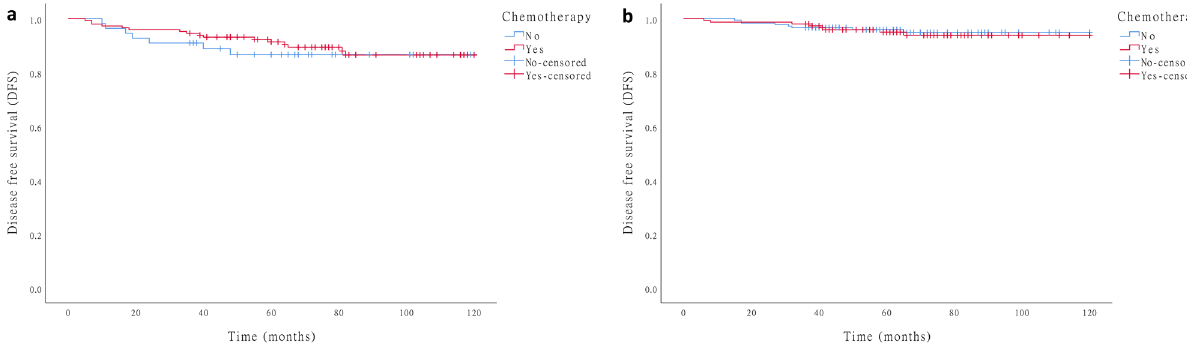
Figure 3: Prognostic impact of adjuvant chemotherapy in patients with stage IB GC, ( a ) T1N1, p = 0.641; ( b ) T2N0, p =